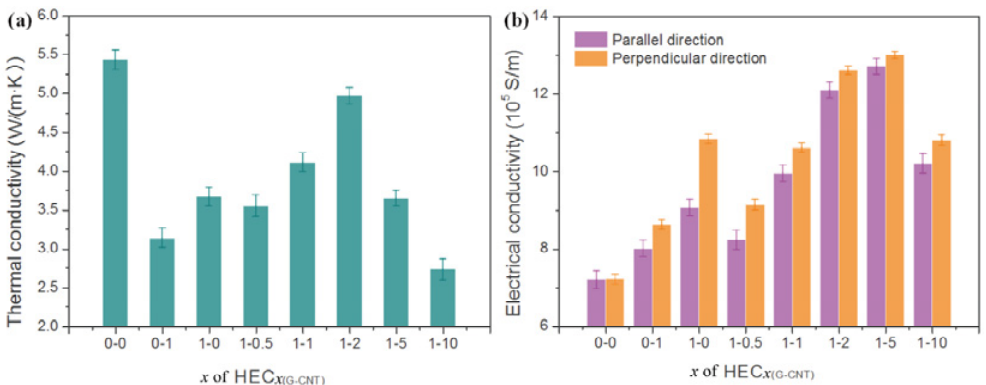
Fig. 6 (a) Thermal conductivity and (b) electrical conductivity of baseline HEC and nanocomposite